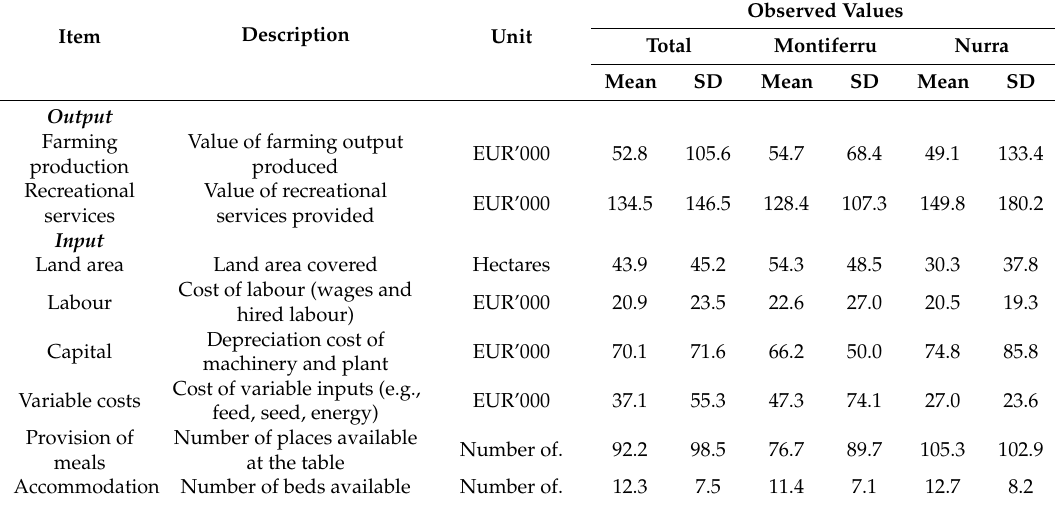
Table 1. Explanatory variables involved in the data envelopment analysis